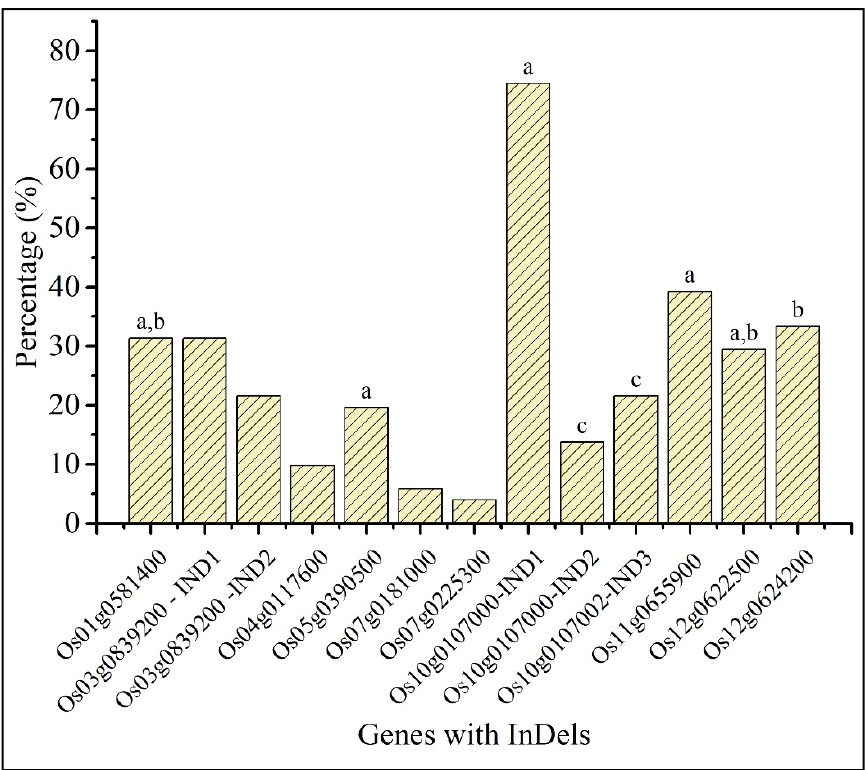
Figure 4. Presence of the InDels in the fifty indica rice panel. Inclusion of salt-tolerant donor varieties; Pokkali-IRIS 313-8244, Nona bokra-IRIS 313-7736 and FL478-CX219 are indicated by a, b, and c